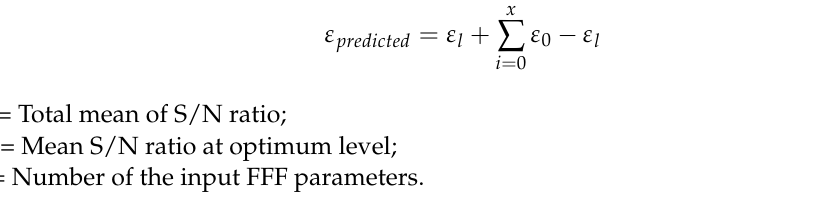
Figure 12. Mean S/N ratio for polymers: ( a ) Ra-PA-6 and ( b )